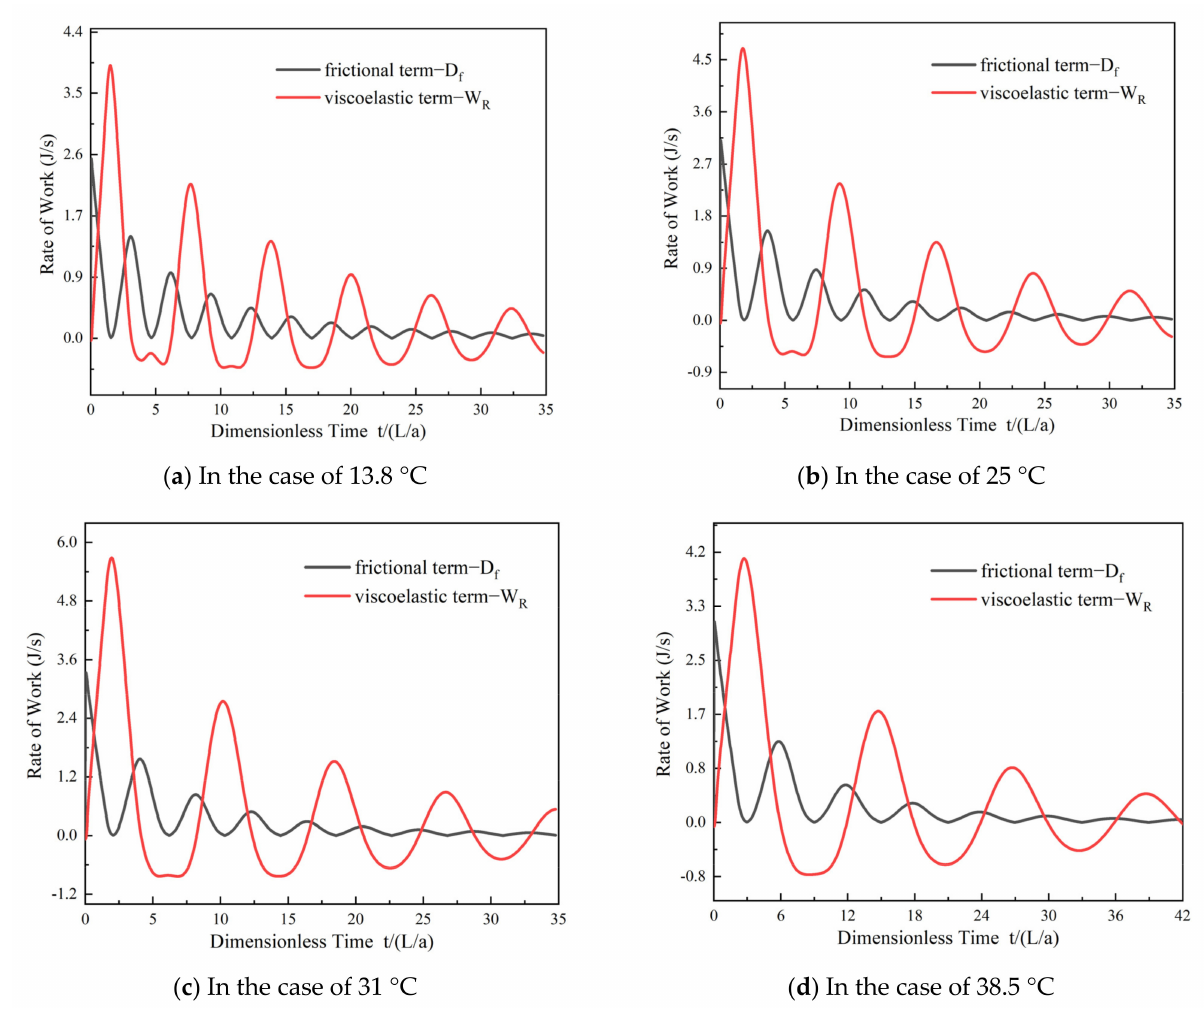
Figure 9. Energy results for the total rate of frictional dissipation and power on the pipe wall at different temperatures: ( a ) 13.8 ◦ C; ( b ) 25 ◦ C; ( c ) 31 ◦ C; ( d ) 38.5 ◦